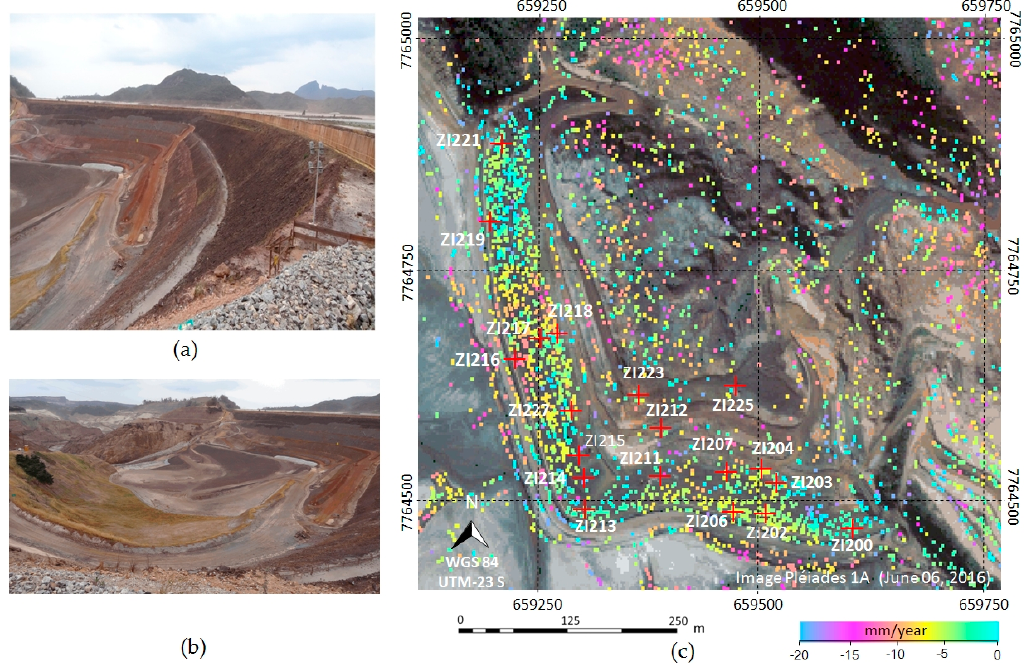
Figure 13. The wall of Sela & Tulipa dike ( a ), the empty Fundão reservoir ( b ) and the PSI ground displacement map showing the positions of the prisms ( c